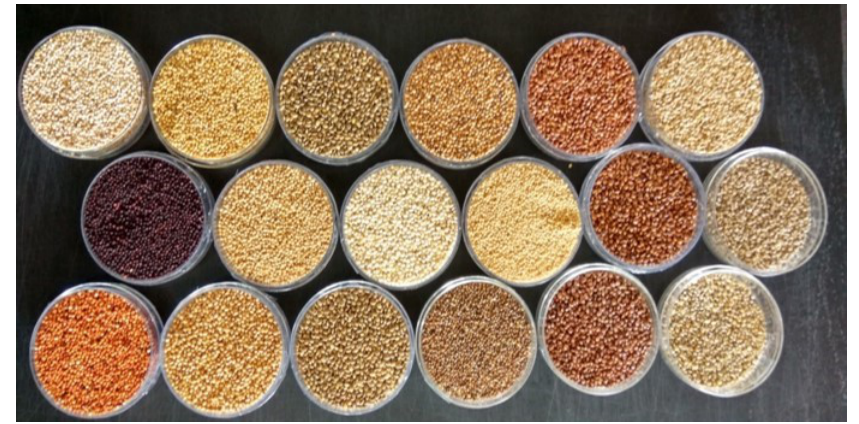
Figure 1. Variability in the proso millet germplasm accessions for seed color.